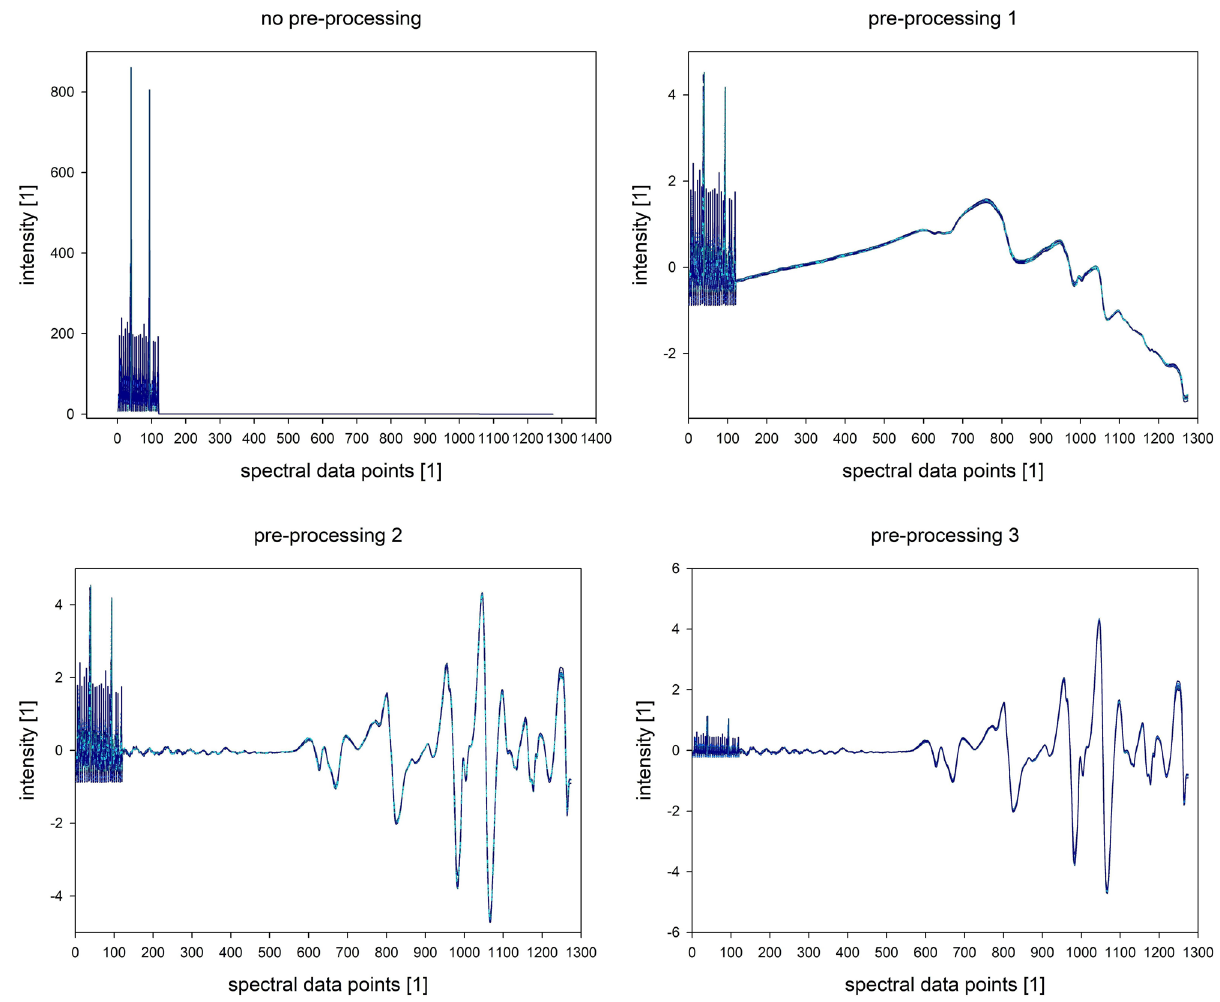
Figure 3. Not and pre-processed spectra of fluorescence (point 1–120) and NIR (121 up)